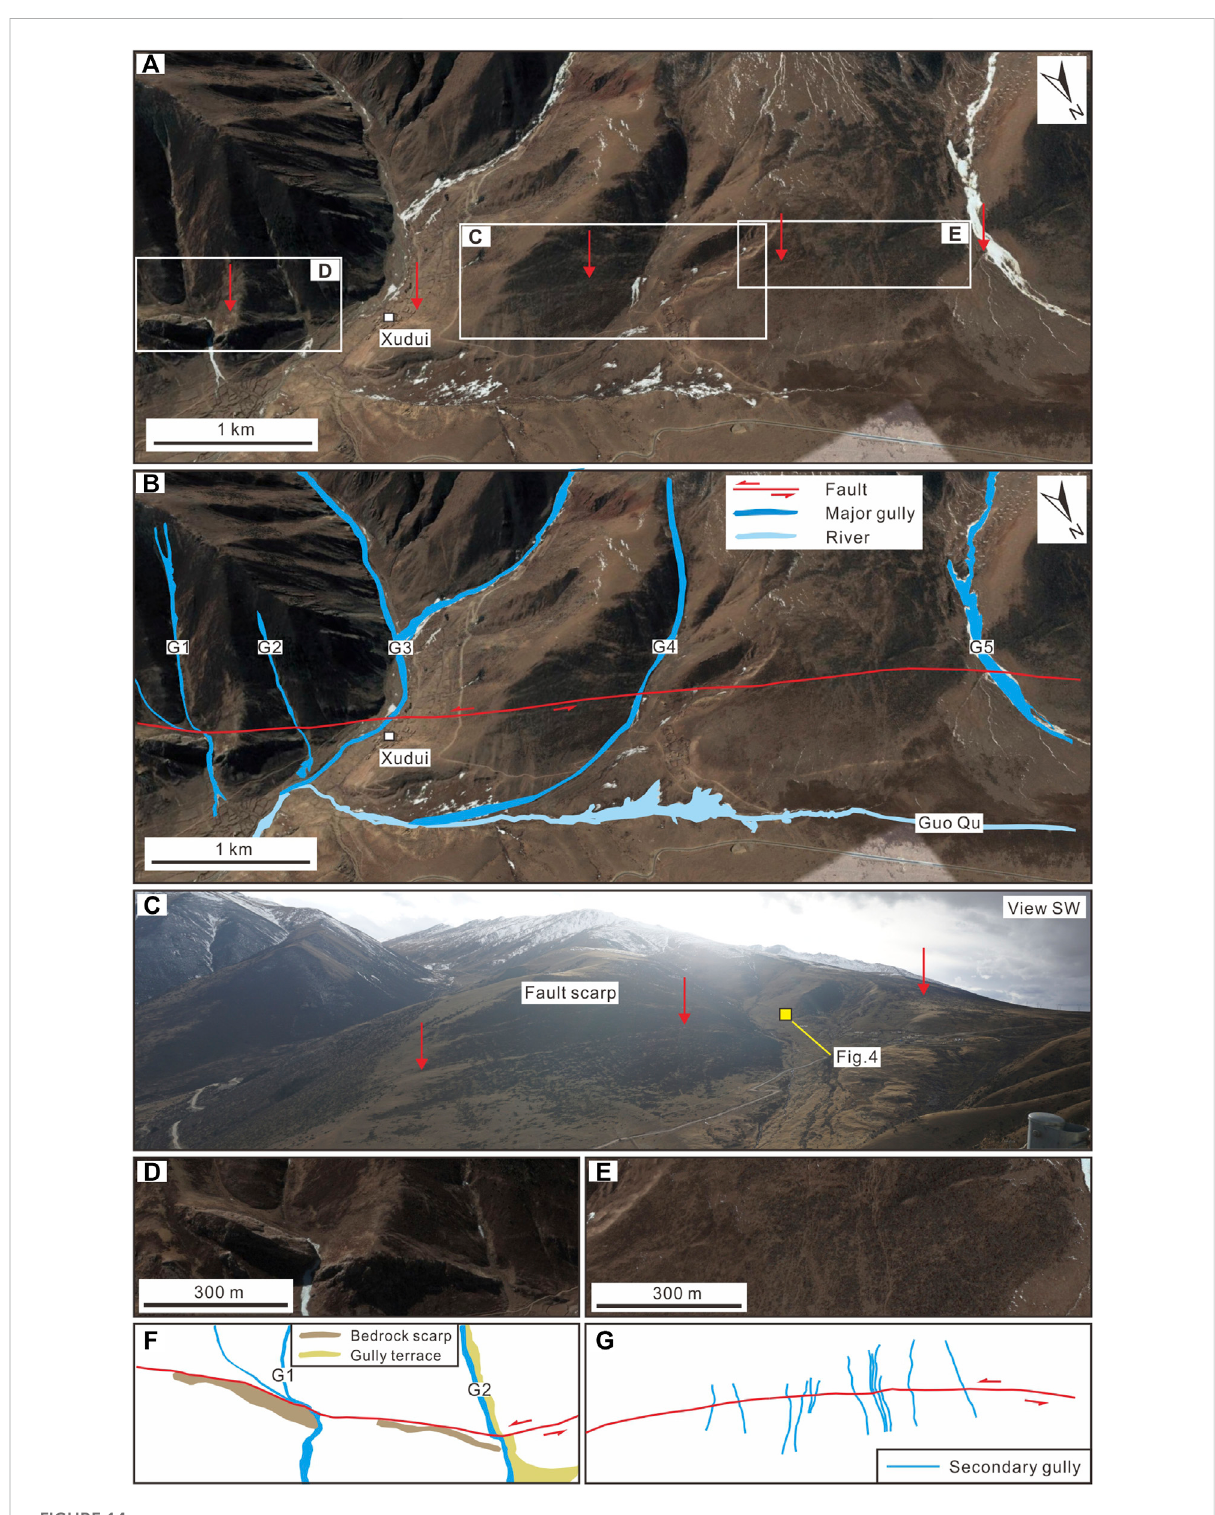
FIGURE 14 OffsetlandformsaroundXuduivillageandlocationoftheXDfaultoutcrop. (A) Satelliteimageand (B) interpretedmapofthetectoniclandforms nearXuduivillage.ThelocationisshowninFigure2.G1 – G5indicatethemajorgullies. (C – E) Localenlargedphotographof (A) . (F) Interpretationmap of the offset landforms in (D) . (G) Interpretation map of the offset landforms in (E)